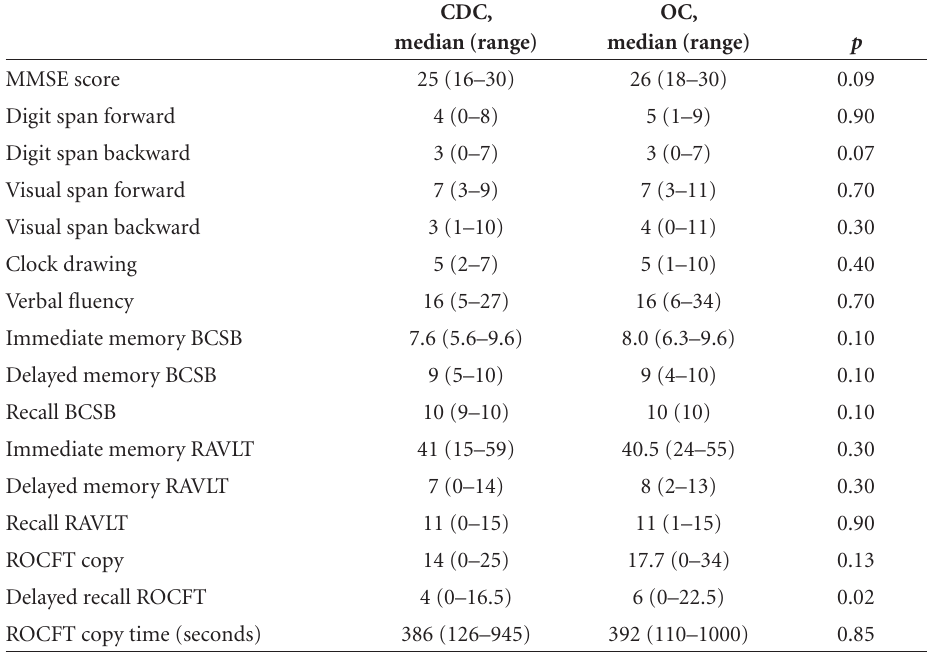
Table 2. Cognitive test scores in patients with Chagas disease cardiomyopathy (CDC) and other cardio- myopathies (OC).